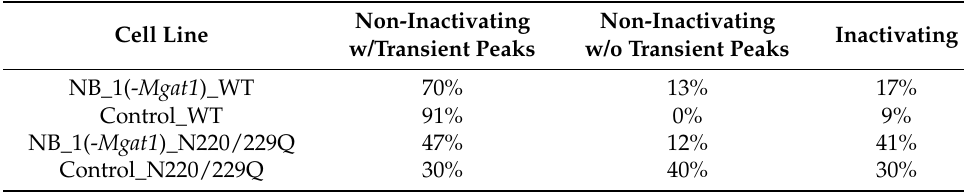
Table 1. Type of current expressed by N-glycosylation mutant and parental cell